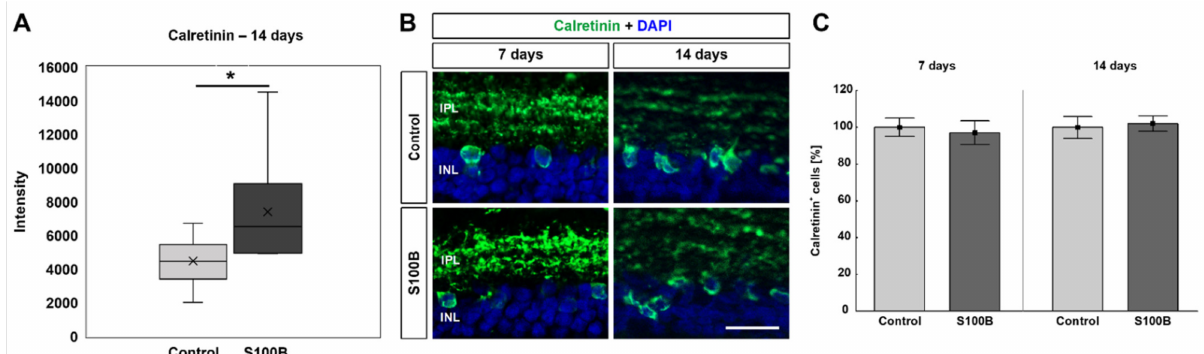
Figure 6. Altered calretinin expression. ( A ) Mass spectrometry analyses showed a significant up- regulation of the calretinin intensity (peptide sequence: GFLSDLLK) 14 days after immunization ( p = 0.023). ( B ) Retinal cross-sections were stained with an anti-calretinin antibody (green) 7 and 14 days after immunization. DAPI was applied to visualize cell nuclei (blue). ( C ) The number of calretinin + cells was not altered at either point in time. Values for immunohistology are mean ± SEM and control values were set to 100%. IPL = inner plexiform layer; INL = inner nuclear layer. Scale bar: 20 µ m. * p <